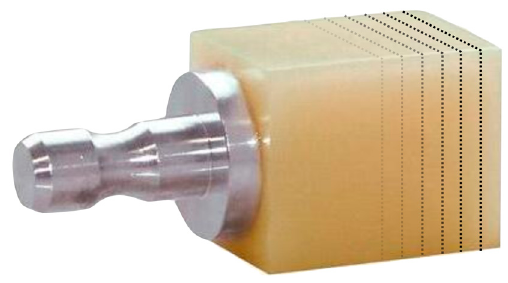
Figure 1. Graphical representation of the cuts performed on the CAD/CAM blocks in order to obtain specimens from different materials. Table 1. Characteristics of the investigated materials.